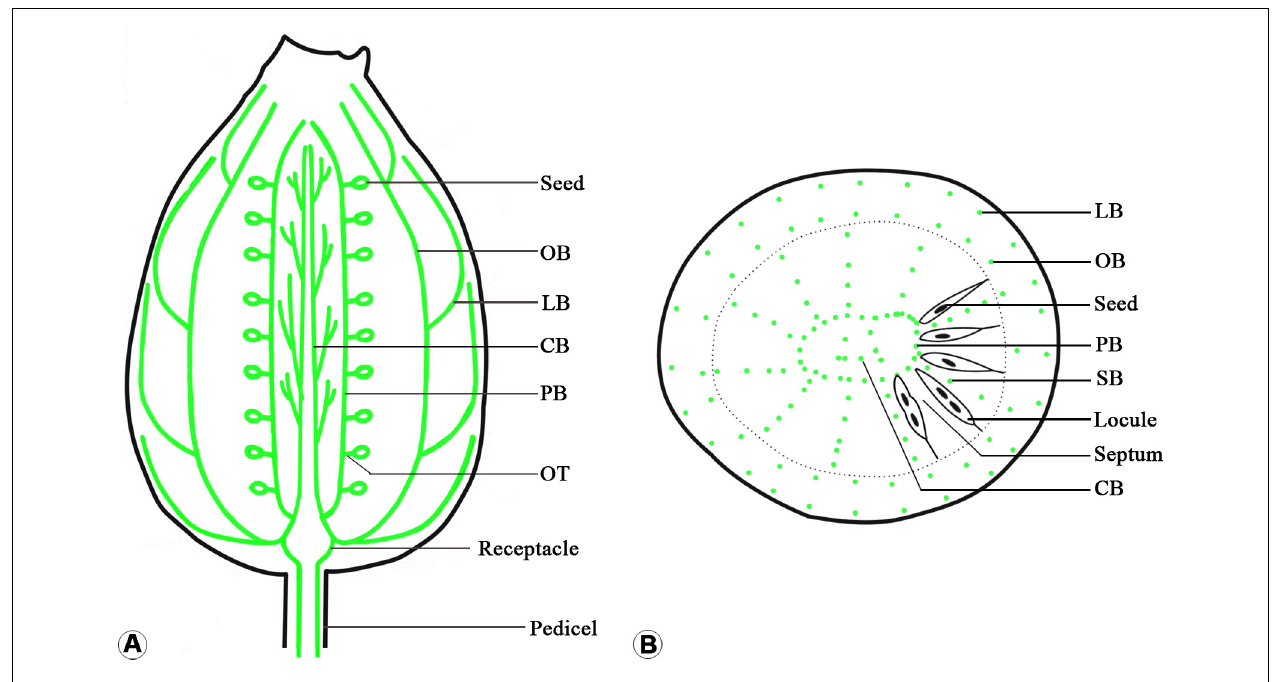
FIGURE 5 | Sketches of the vascular distribution of fruit of Actinidia deliciosa var deliciosa ‘Qinmei.’ (A) Longitudinal mid-section of fruit, showing the arrangement of the major vascular bundles in fruit. (B) Mid-cross section of fruit, showing the distributions of the major